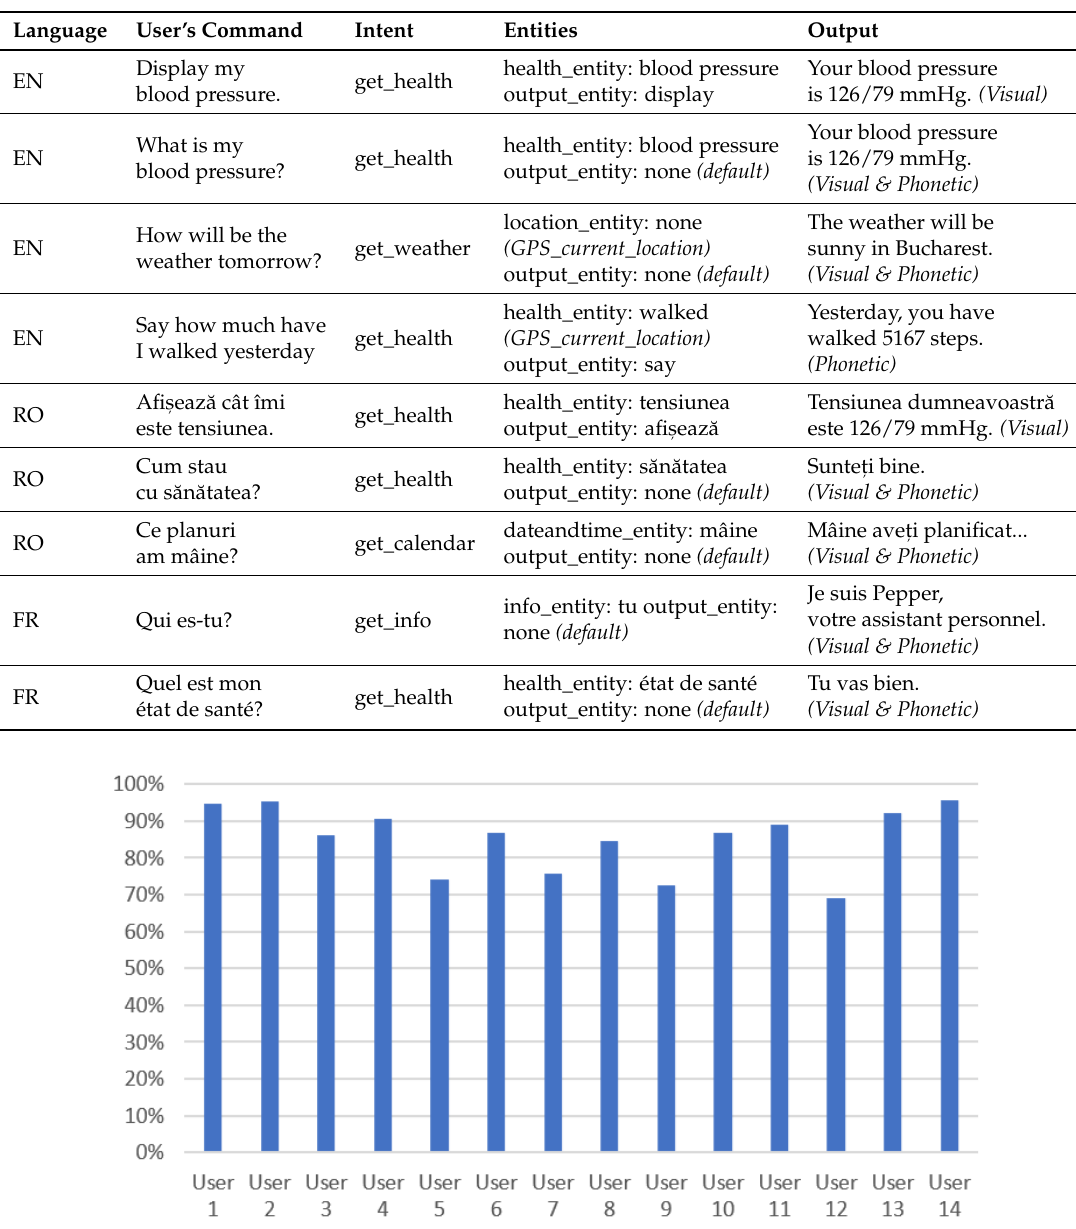
Table 3. Samples of the evaluation results for the dialogue module.